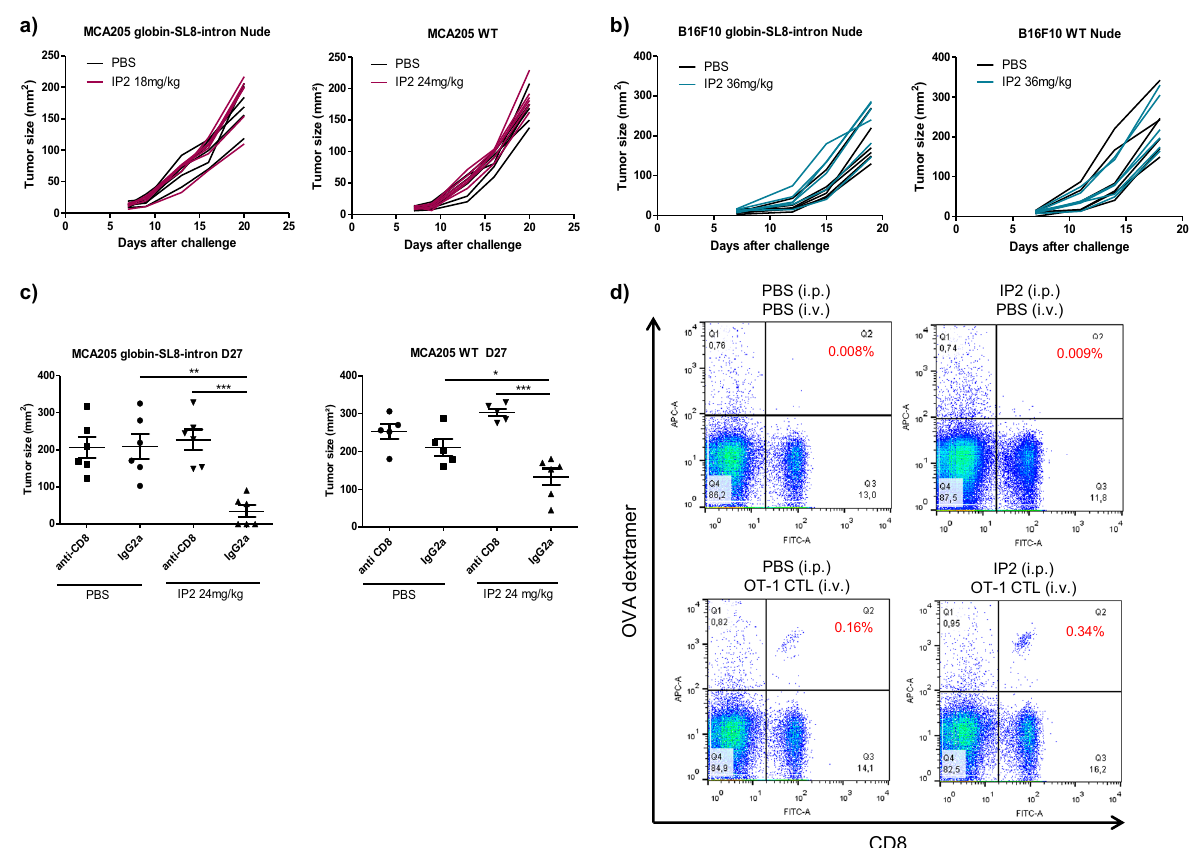
Fig. 4 IP2 therapeutic effect is dependent on the adaptive immune response. Individual tumor growth kinetics of ( a ) MCA205 fi brosarcoma stably expressing the globin-SL8-intron construct (left panel) and MCA205 fi brosarcoma WT (right panel) and ( b ) B16F10 melanoma stably expressing the globin-SL8-intron construct (left panel) and B16F10 melanoma WT (right panel) subcutaneously inoculated into the right fl ank of immunode fi cient nude mice thereafter treated at days 5, 10, and 15 with 18 mg/kg of IP2. c Tumor size at killing of MCA205 fi brosarcoma stably expressing the globin-SL8-intron construct (left panel) and MCA205 fi brosarcoma WT (left panel) subcutaneously inoculated into the right fl ank of immunocompetent C57BL/6 mice thereafter treated with 24 mg/kg of IP2 at days 5, 10, and 15 and CD8 + T-cell depleting antibody every three days. Data are given as mean ± SEM of tumor size for six mice per group. d Analysis by fl ow cytometry of SL8-speci fi c OT-1 CD8 + T-cell proliferation after intravenous adoptive transfer of OT-1 CD8 + T cells into immunocompetent C57BL/6 mice bearing MCA205-globin-SL8-intron fi brosarcoma and treated with 24 mg/kg of IP2. Data highlight the frequency of SL8-speci fi c OT-1 CD8 + T cells (top right quadrant) in the spleens and are representative of fi ve mice per group. * P < 0.05, ** P < 0.01, *** P < 0.001 (One-way